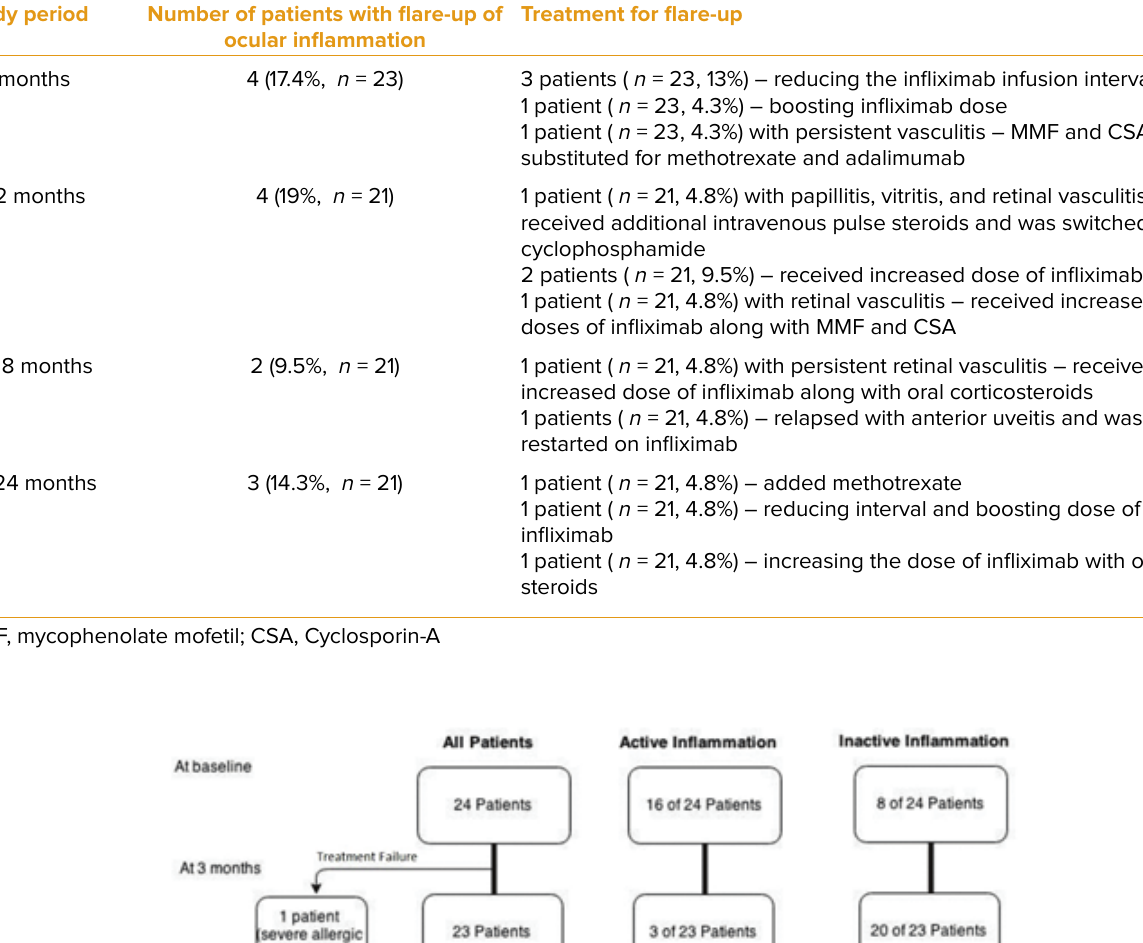
Table 4. Management of patients with ocular inflammation flare-up during the study period Study period Number of patients with flare-up of Treatment for flare-up ocular inflammation